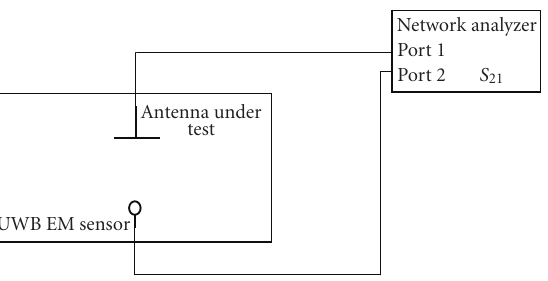
Figure 11: Transmit waveform measurement